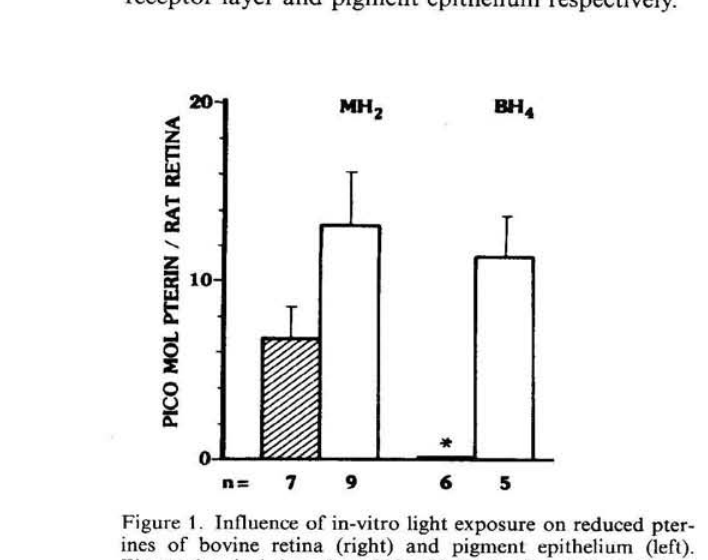
Figure 1. Influence of in-vitro light exposure on reduced pter- ines of bovine retina (right) and pigment epithelium (left). Electrochemical detection: 800 mV, 1 nA. The dark and light columns indicate dark and light illumination